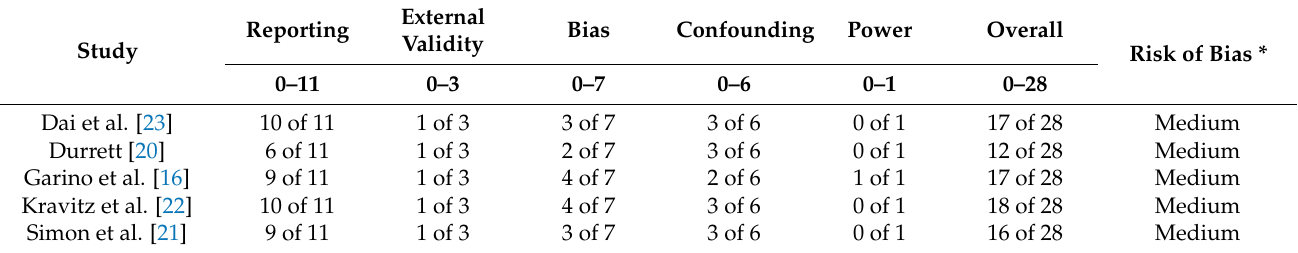
Table 3. Results of risk of bias evaluation performed for clinical studies according to the Downs and Black scale